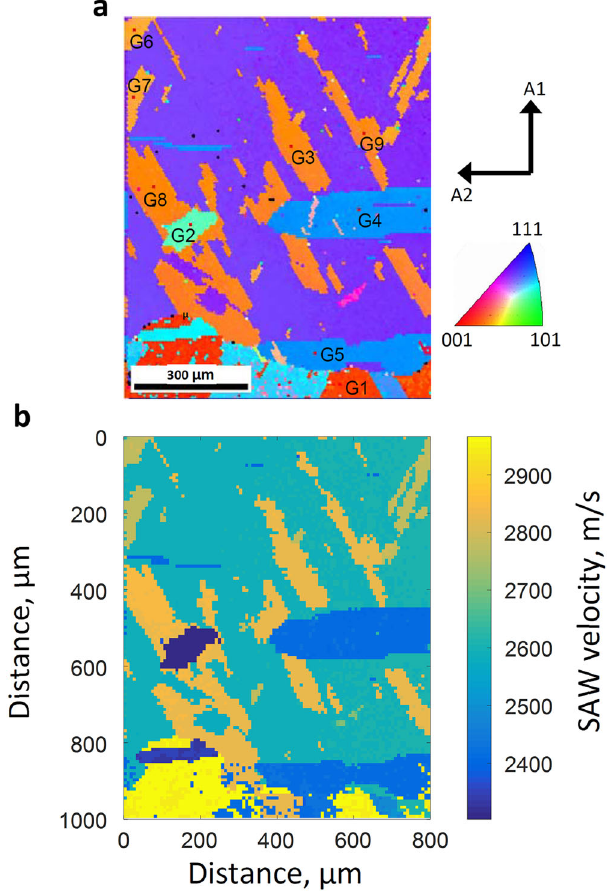
Fig. 3 EBSD orientation map ( a ) and the computed SAW velocity map ( b ) along horizontal propagation direction using the SAW solution model with the elastic constants and density of pure Ni as well as the EBSD orientation as the input to the